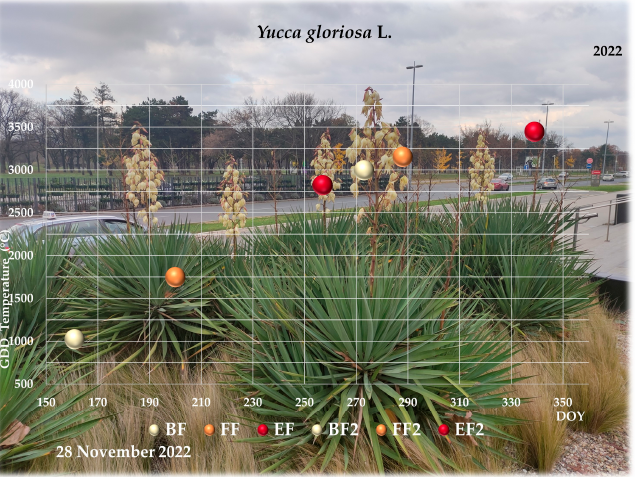
Figure 15. Phenological observations: GDD and DOY for the beginning of first flowering (BF), full first flowering (FF), the end of first flowering (EF), the beginning of second flowering (BF2), full second flowering (FF2), and the end of second flowering (EF2) for Spanish Dagger in 2022.